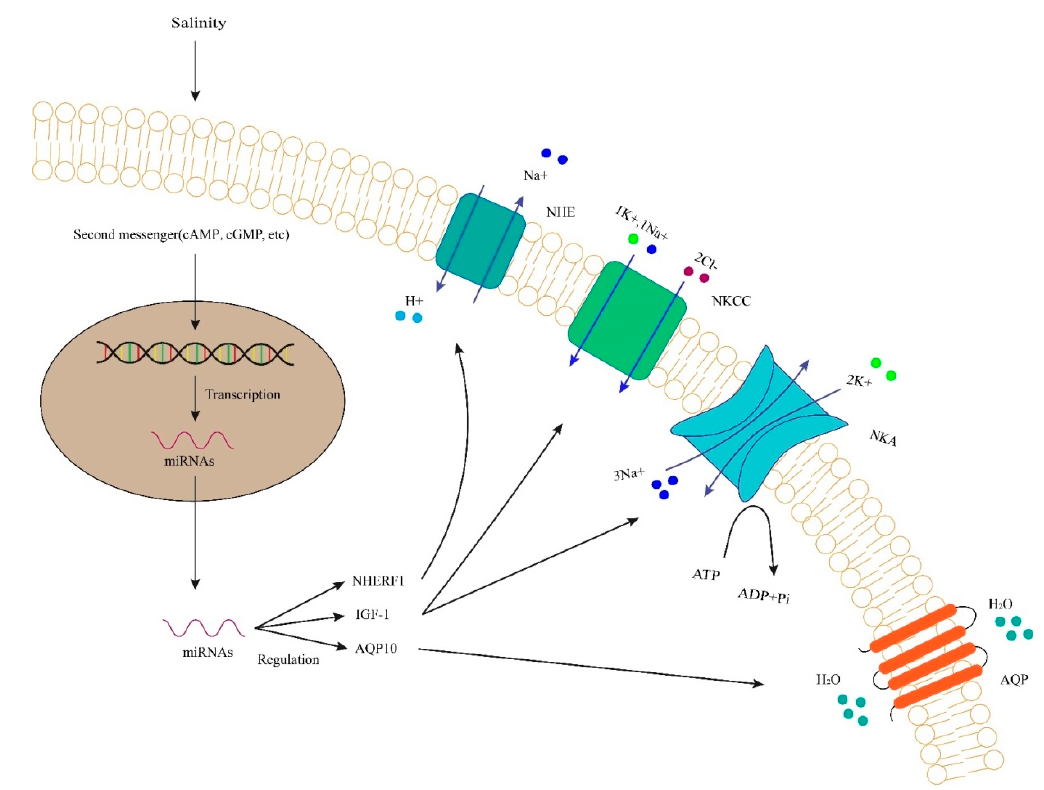
Figure 1. Regulation of NHE, NHERF1, NKA, NKCC, IGF-1 and AQP, etc., by miRNAs under salinity in fish. Second messengers induce the transcription of DNA. miRNAs regulate gene expression and function in target genes. They regulate transcription of the target genes and protein synthesis. NHE, mean Na + /H + -exchanger; NHERF, Na + /H + exchanger regulatory factor 1; NKCC, mean Na + -K + -2Cl- cotransporter; NKA, mean Na + /K + -ATPase; AQP, mean Aquaporin; IGF, mean insulin growth factor. In the Atlantic killifish ( Fundulus heteroclitus ), several potassium voltage-gated channel homologues are the targets of miRNA-135b. The response of miRNA-135b to